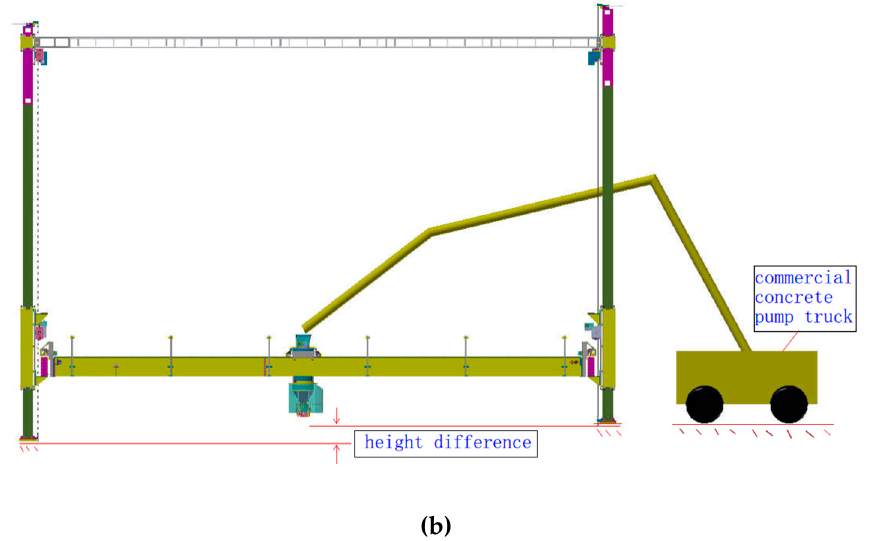
Figure 1. Column-type 3D printer for ready-mixed concrete: ( a ) Axonometric view and ( b ) Elevation view.